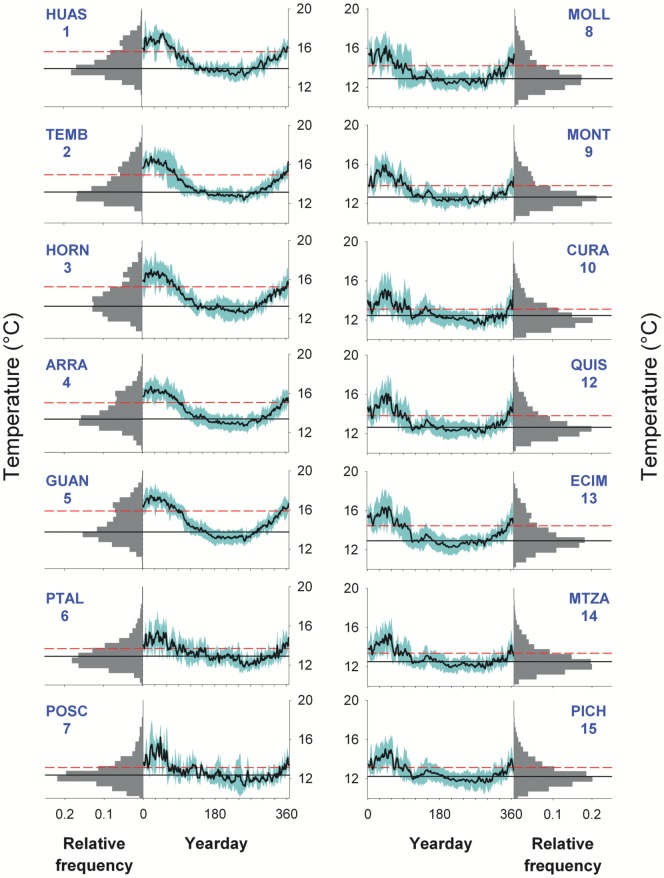
Statistical description of in situ temperature records at 14 of the study sites.Bar and time-series graphs correspond to frequency distributions and climatologies of water temperature, respectively. Shaded areas around climatologies represent interannual variability (±1SD). Solid and dashed horizontal lines correspond to fall-winter and spring-summer mean values, respectively. Numbers and four-letter acronyms on each panel correspond to site numbers and names (see Fig. 1 and Table 1).